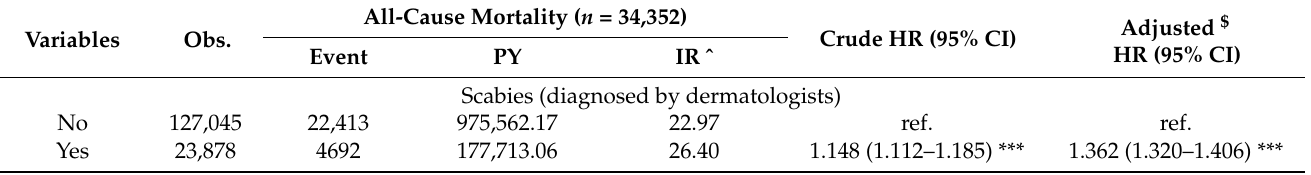
Table 6. Sensitivity analysis for the risk of all-cause mortality between scabies and non-scabies